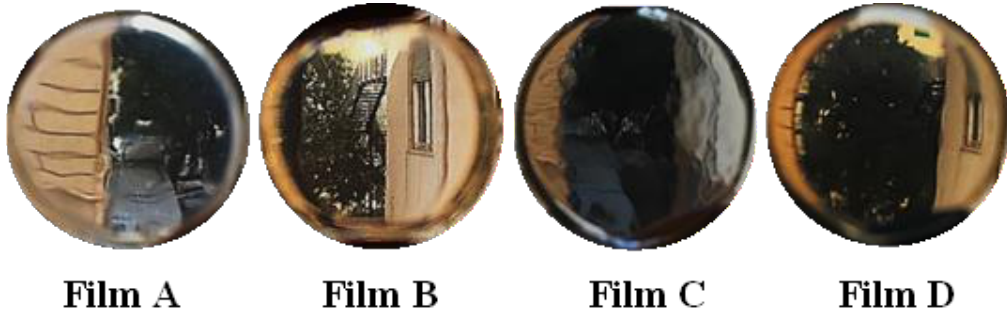
Figure 1. Appearance of the freshly prepared CYT-loaded Buccal Films.